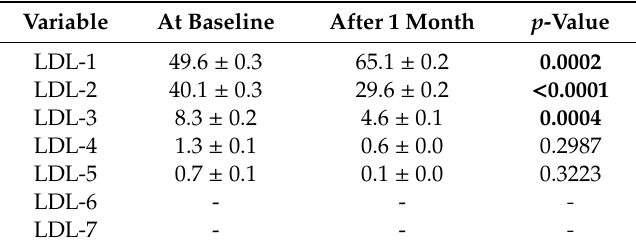
Table 4. E ff ect of OFI-supplemented pasta on the percentage distribution of LDL subfractions. Data are expressed as mean ± SD. In bold, the p -values that reached statistical